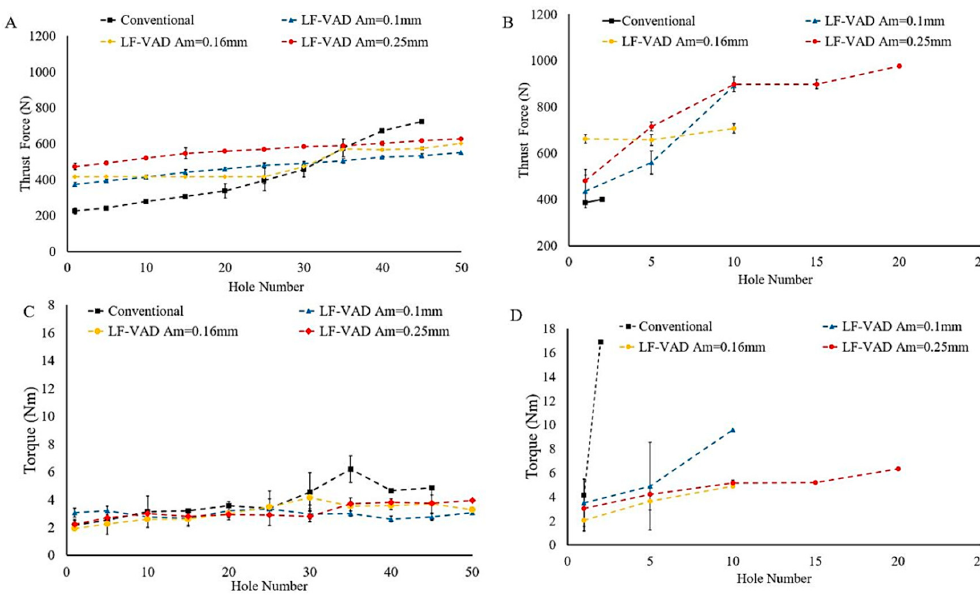
Figure 3. The e ff ect of tool wear progress on the thrust force and cutting torque at di ff erent vibration Figure 3. The effect of tool wear progress on the thrust force and cutting torque at different vibration amplitude for N = 56.52 m / min: ( A , C ) f = 0.025 mm / rev and ( B , D ) f = 0.075 mm / amplitude for N = 56.52 m/min: ( A , C ) f = 0.025 mm/rev and ( B , D ) f = 0.075 mm/rev.